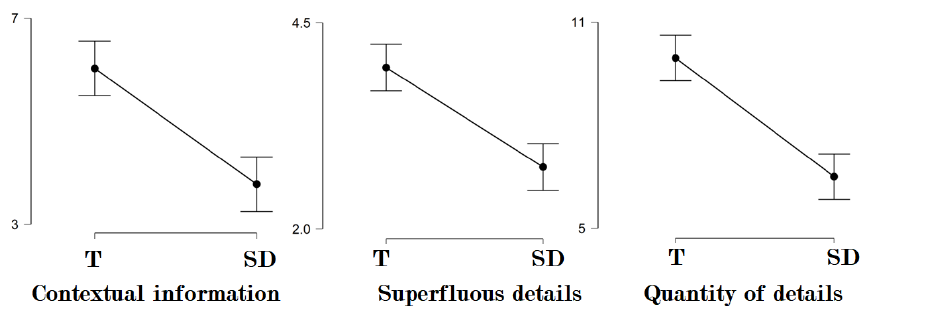
Figure 1. Error bar charts for linguistic style conditions under analysis with statistically significant differences across True (T) and Simulated Deception (SD)